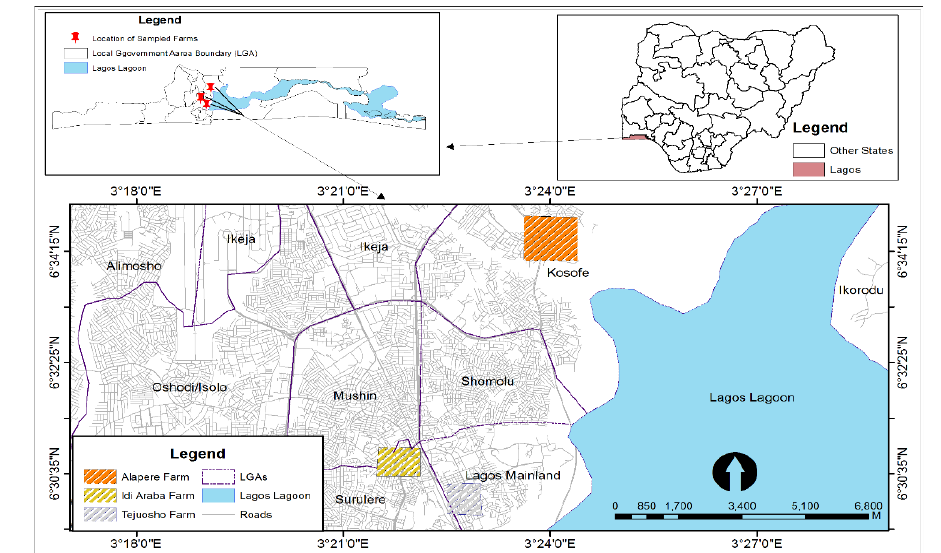
Fig. 1. Map of Nigeria (top right) showing Lagos State (top left) and sampling locations